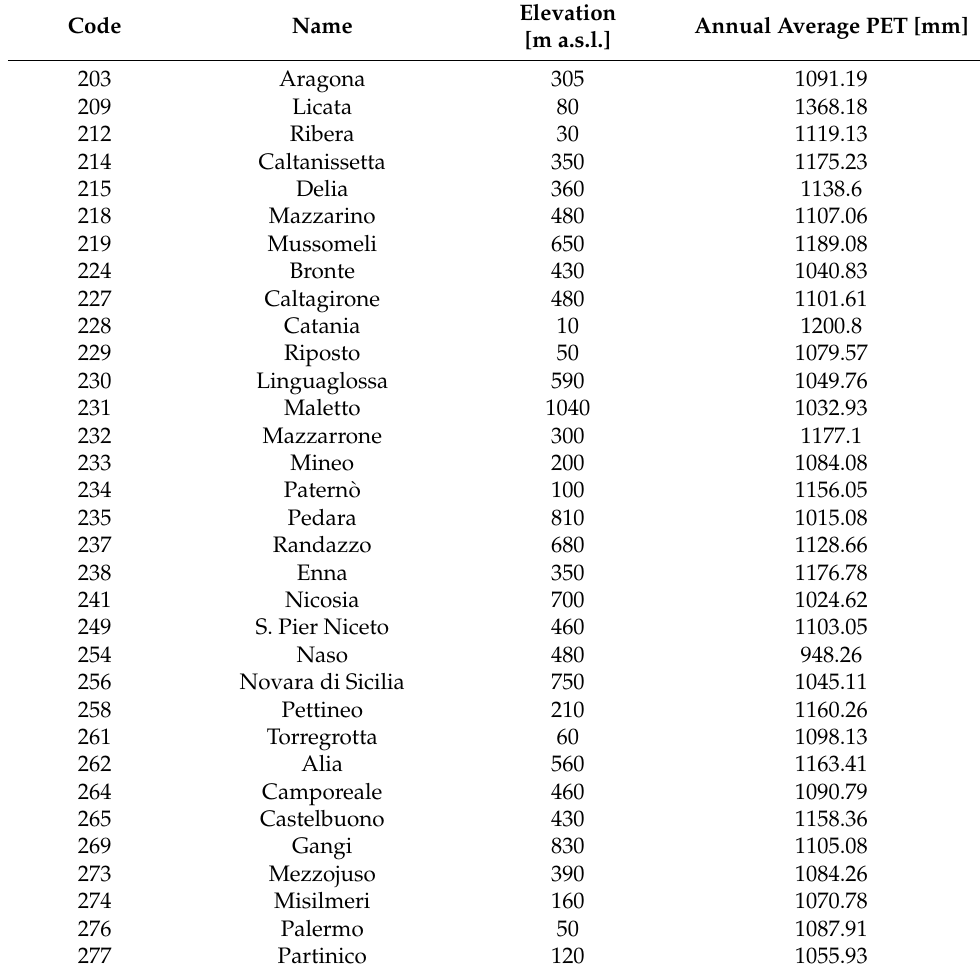
Figure 1. Study area with location of meteorological stations of the SIAS network. Table 1. Main characteristics of the SIAS network meteorological stations.